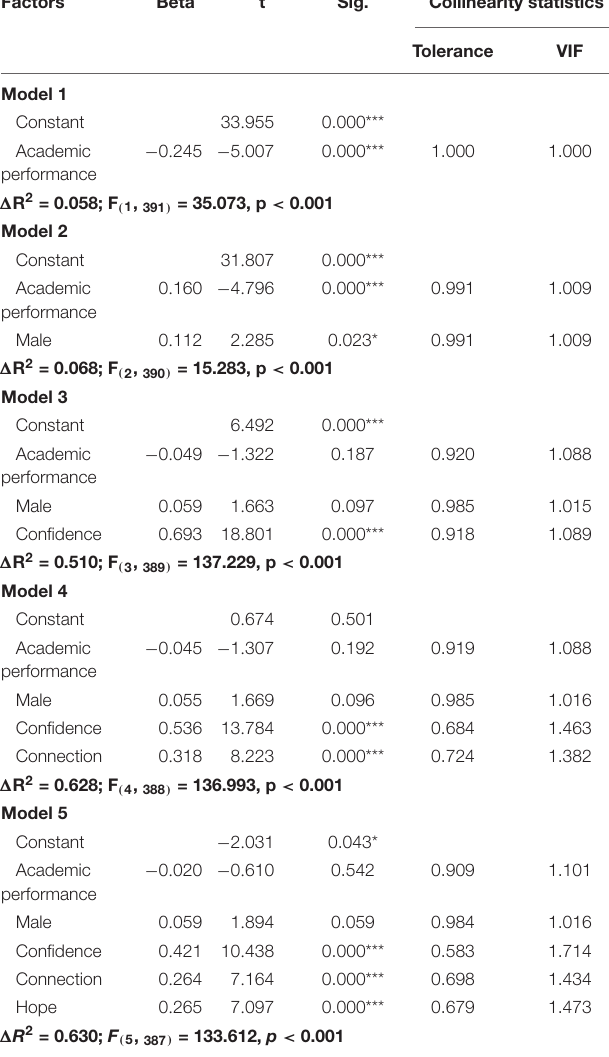
TABLE 3 | Hierarchical regression analysis (Stepwise): Well-Being in Relation to 5Cs of PYD, purpose in life, and hope ( N = 393). Factors